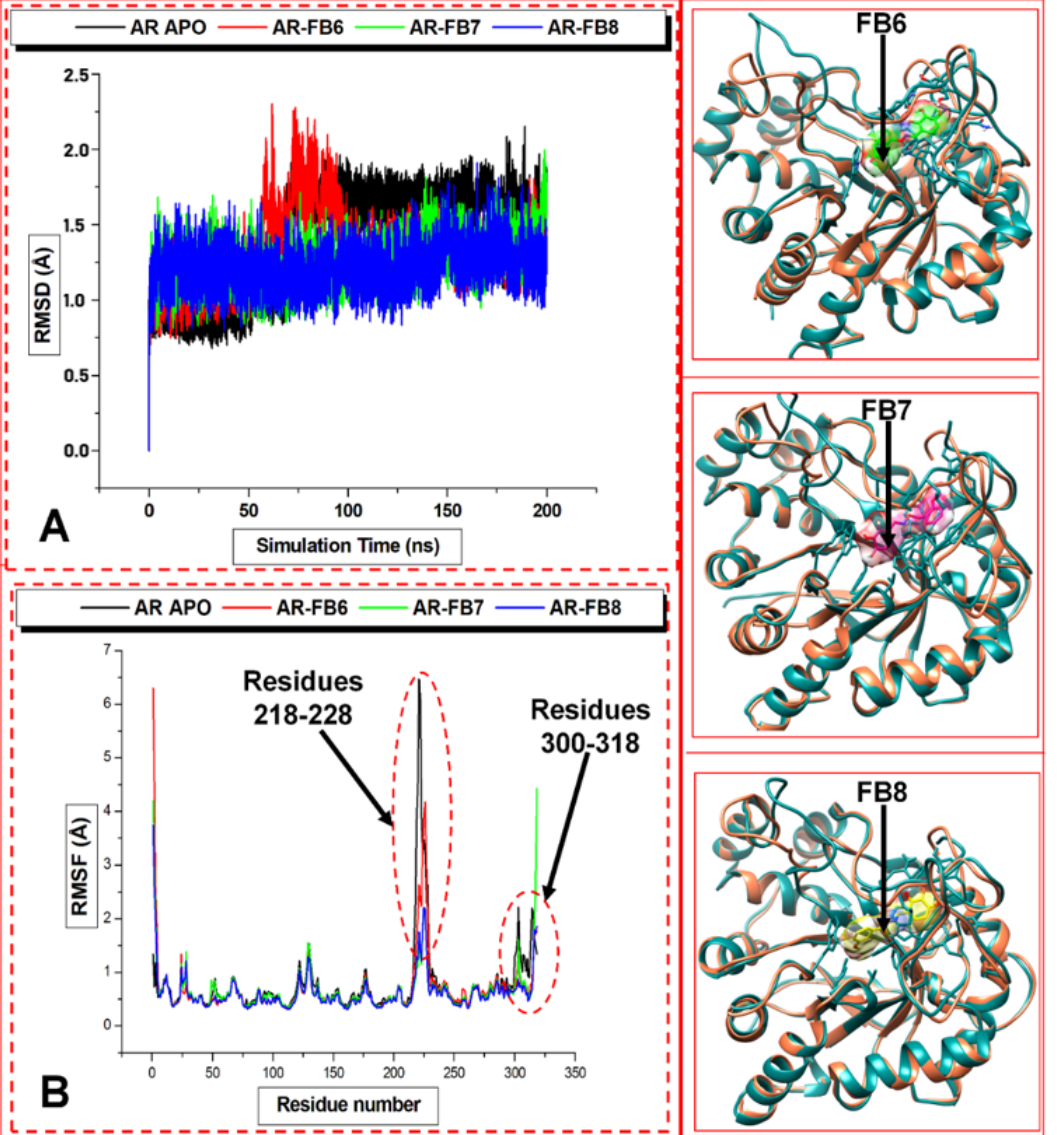
Figure 7. RMSD ( A ) and RMSF ( B ) plots for the unbound protein (black, working code AR–Apo), and the complex with 8b (red, working code AR-FB6), 6b (green, working code AR-FB7) and 7b (blue, working code AR-FB8). The structures C, D, and E are simulated ALR2- 8b , ALR2- 6b , ALR2- 7b complexes at 200 ns superimposed with the ALR2–Apo system.